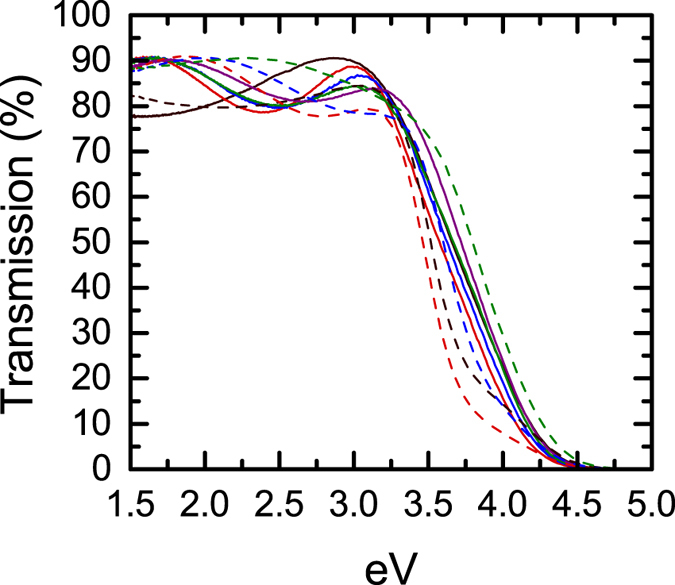
Transmission of the a-IGZO and ZnO:Al based superlattices.(—) 100 nm a-IGZO, () 10/2.5 nm a-IGZO/SiOx superlattice, () 10/5 nm a-IGZO/SiOx superlattice, () 10/7.5 nm a-IGZO/SiOx superlattice, () 10/10 nm. a-IGZO/SiOx superlattice, (---) 80 nm ZnO:Al, () 10/2.5 nm ZnO:Al/SiOx superlattice, () 10/5 nm ZnO:Al/SiOx superlattice, () 10/10 nm ZnO:Al/SiOx superlattice.